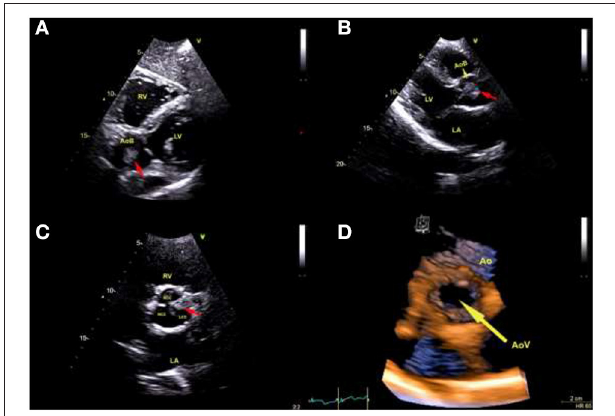
FIGURE 1 | Transthoracic echocardiography: (A) Subxyphoid view shows pedunculated mass (red arrow) localization in Valsalva sinus. (B) Long-axis view measuring tumor size 1.9 × 1.5cm (red arrow). (C) Short-axis view at aortic valve level demonstrates tumor (red arrow) originating immediately after the separation of the left and right coronary cusp. (RV) Right ventricle. (LV) Left ventricle. (AoB) Aortic bulb. (LA) Left atrium. (RCC) Right coronary cusp. (NCC) Noncoronary cusp. (LCC) Left coronary cusp. (D) Transthoracic three-dimensional echocardiography: view of the aortic valve (yellow arrow) from the aortic side, which shows the aortic cusps’ normal appearance. (AoV) Aortic valve. (Ao)